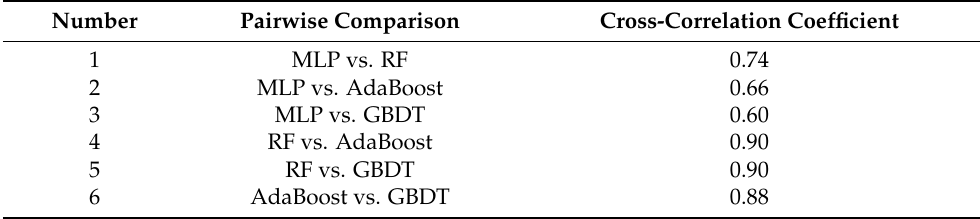
Table 5. The results of cross-correlations among the four models.